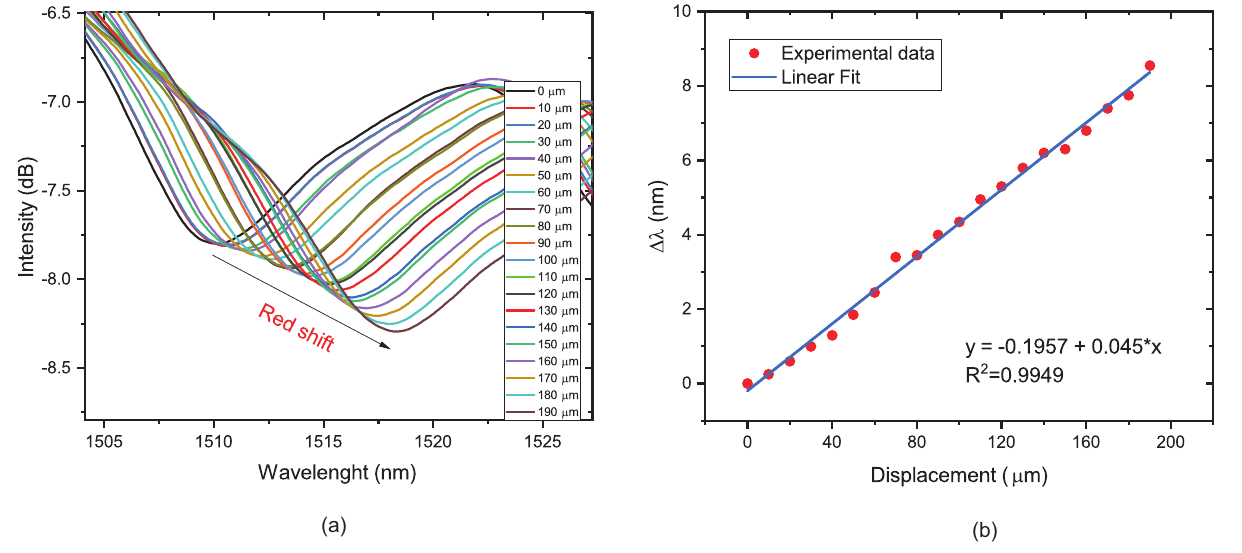
Figure 8. ( a ) Transmission spectra response for 6 mm of radius of curvature. ( b ) Dip wavelength changes as a function of the micro-displacement